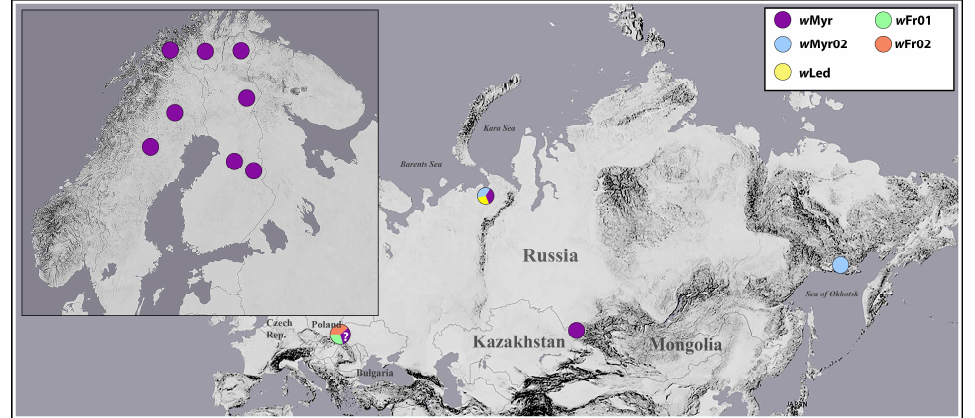
Figure 3. Map showing geographical distribution of revealed Wolbachia wsp alleles.